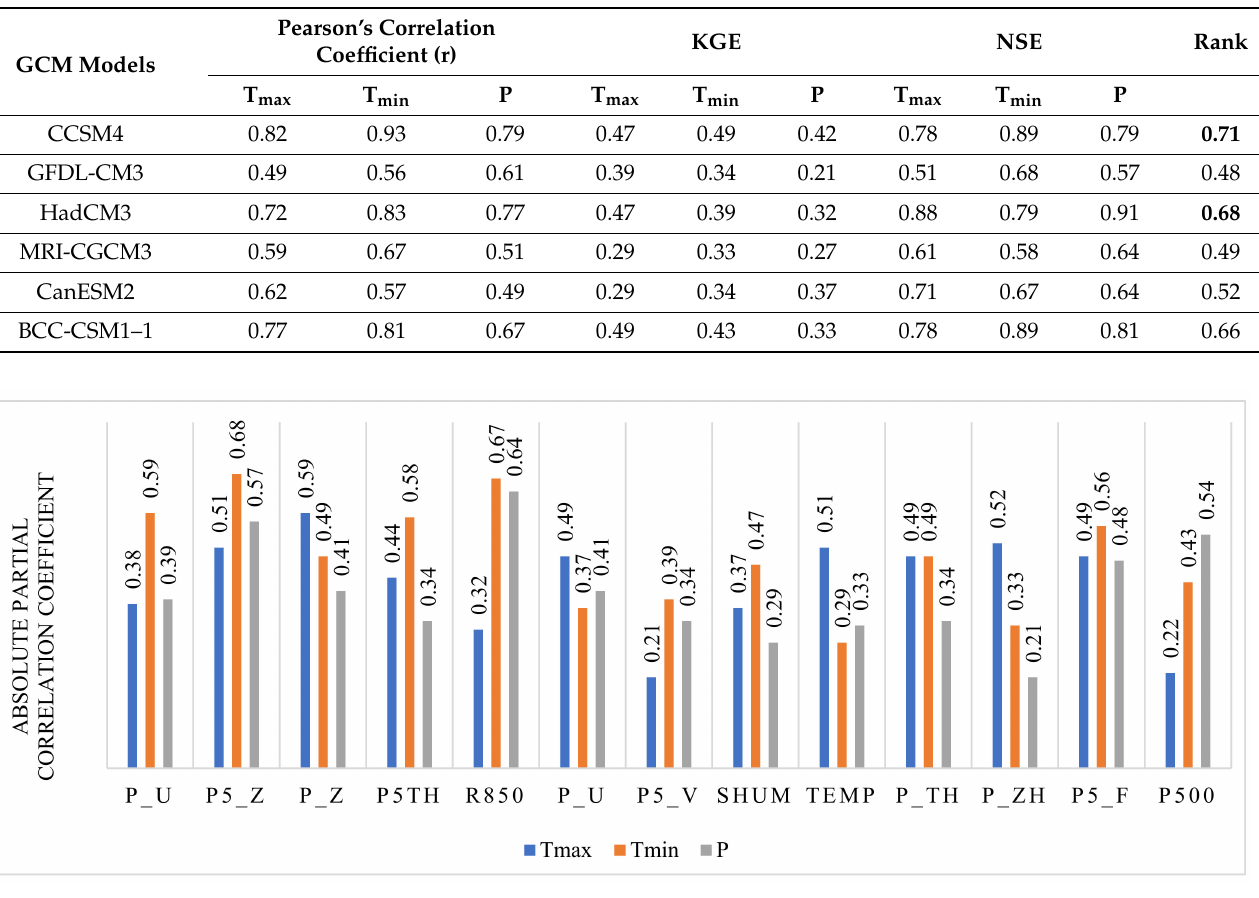
Figure 2. Selected predictors against predictands (T max , T min and